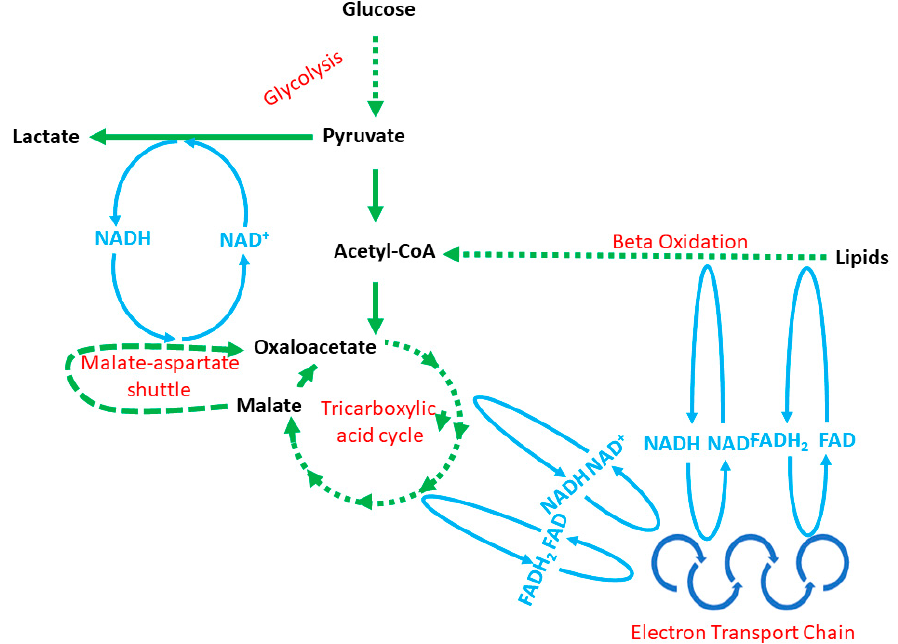
Figure 1. The relationships between energy production pathways: cytoplasmic glycolysis, the mitochondrial tricarboxylic acid cycle, the mitochondrial electron transport chain, the malate–aspartate shuttle and mitochondrial and/or peroxisomal fatty acid β -oxidation. Note: the NADH/NAD+ and FADH 2 /FAD blue reaction lines do not reflect the exact place in a particular cycle, but show the connections existing between metabolic pathways. Table 1. Metabolic enzymes identified in neuroblastoma cell-derived exosomes. Enzyme